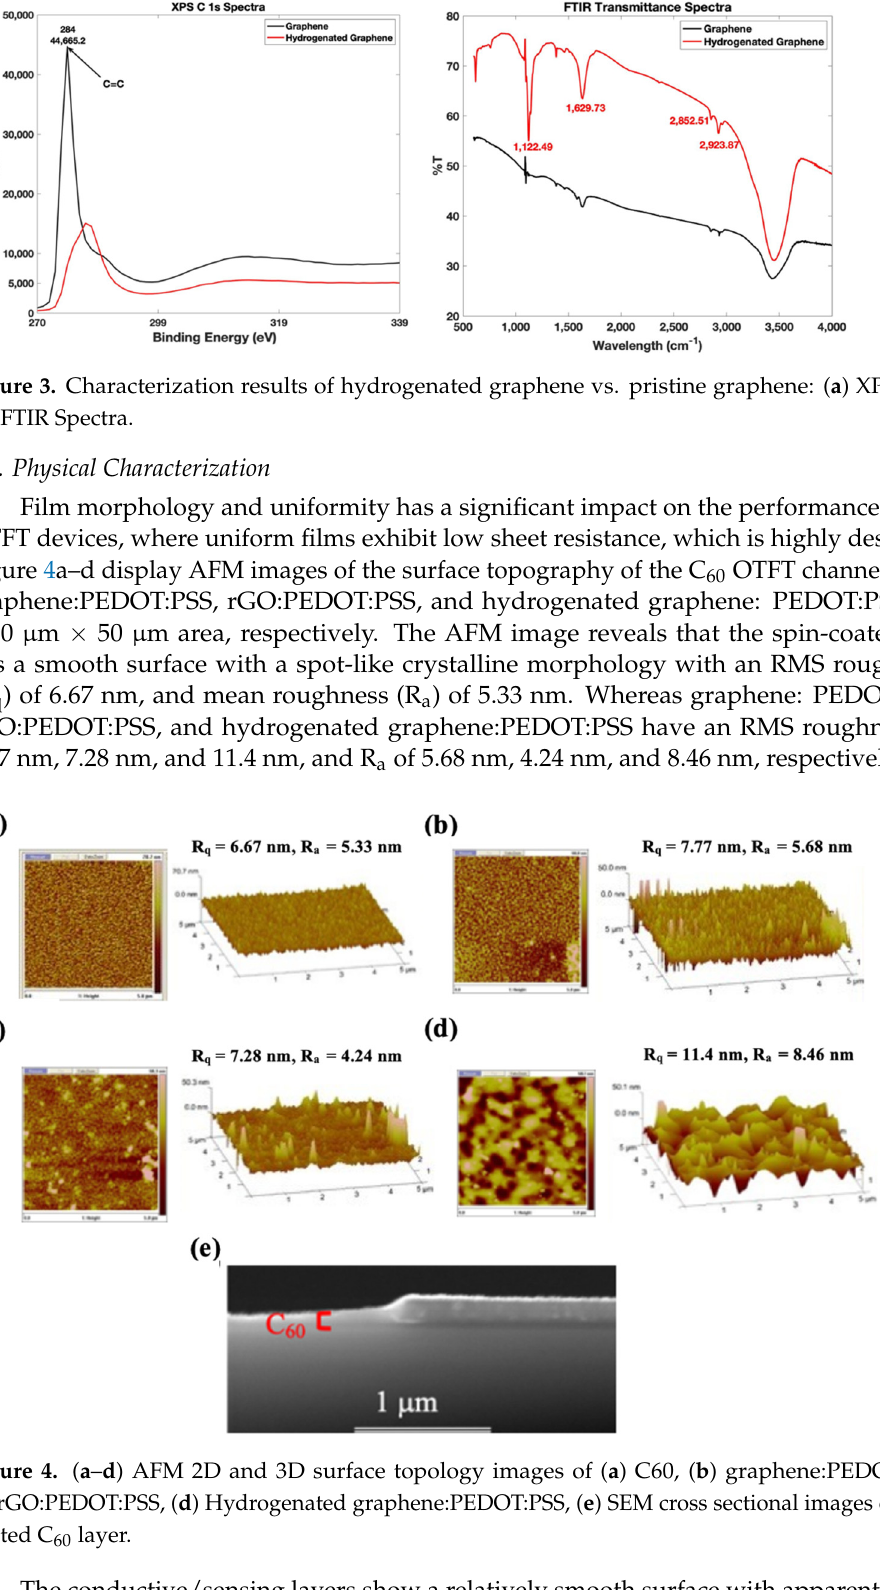
Figure 5 . Charge mobility characterization: ( a ) SCLC current transient, ( b ) measured charge mobil- ity vs. applied voltage. observed in Figure 5a indicates the arrival time of the fastest charge carriers to the non-injecting contact. Beyond that point, the current density decreases until it reaches the equilibrium state analogous to charge dynamic equilibrium. The observed increase in cur- rent transient with increasing voltage featuring a shift of the current peak to lower values is indicative of the formation of ohmic contact typical to DI SCLC transients. Figure 5b summarizes the electron mobilities obtained from Dark Injection Space Charge Limited Current measurements showing higher mobilities in the low voltage region and a